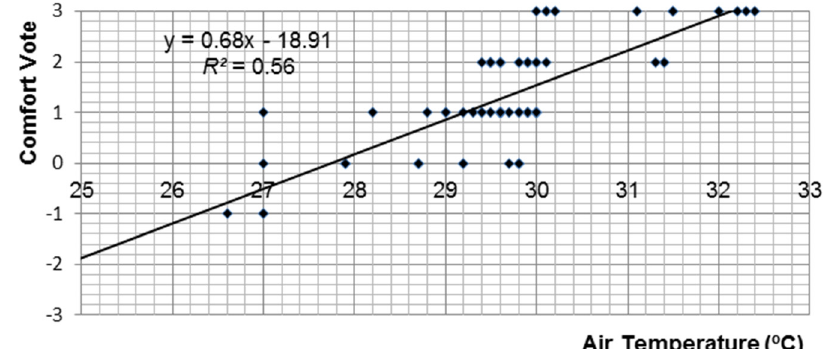
Figure 5. Regression line of thermal sensation vote on air temperature in the museum.